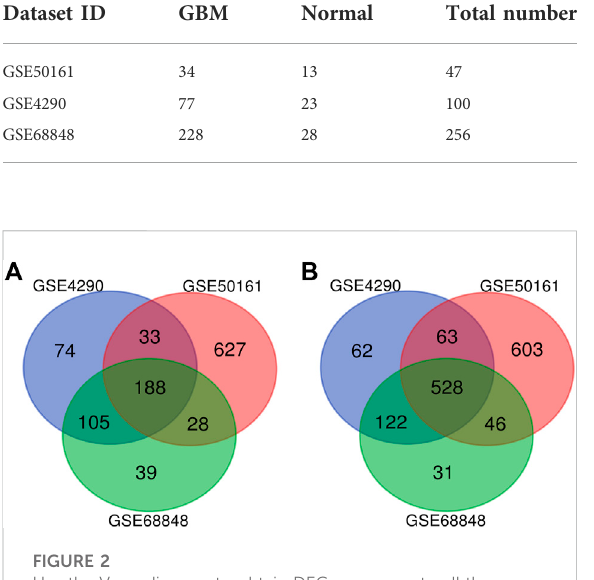
FIGURE 2 Use the Venn diagram to obtain DEGs common to all three GEO datasets.The red,blue,andgreencolorsrepresent GSE4290, GSE50161, and GSE68848, respectively; 716 DEGs were identi fi ed as signi fi cantly differentially expressed among all three groups. (A) 188 upregulated common genes were found in the three datasets. (B) 528 downregulated genes were found in the three datasets. DEGs: differentially expressed